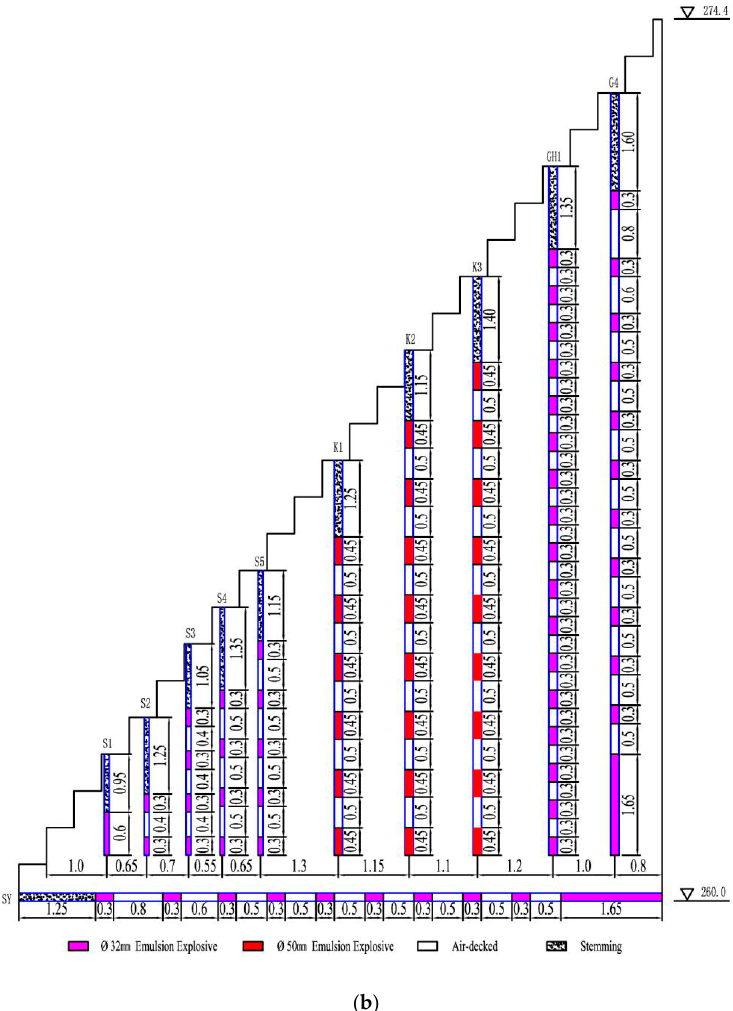
Figure 5. Typical blast parameters of region I. ( a ) Blast network structure, ( b ) A-A’ profile charge structure (unit:m).